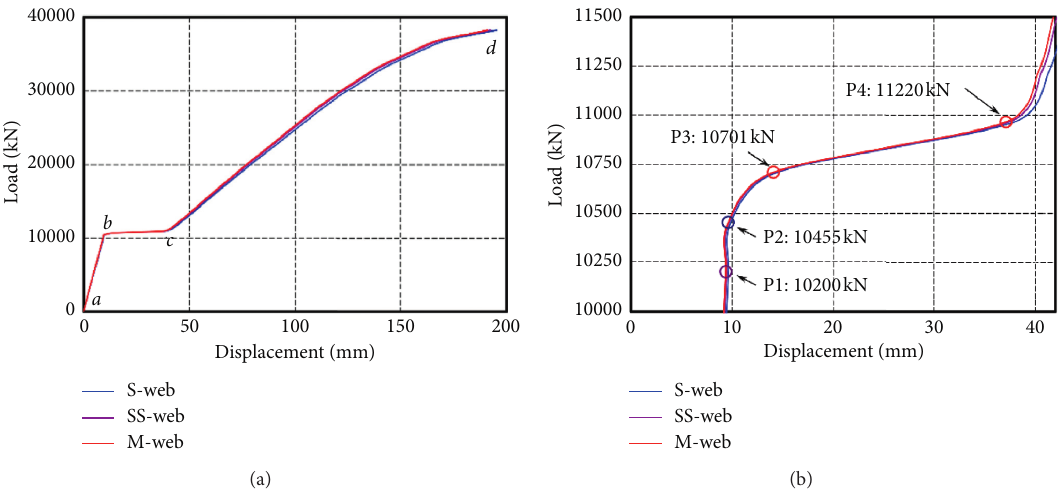
Figure 9: Load-displacement load shear force distribution factor of the S-web From Figure 12: increased to 1.41 ( P � 10965). As the load continued (1) In the elastic phase, the dead load shear force dis- tribution factor remains the same even if the external load changes. The dead load shear force distribution factor of the S-web is greater than 1.0. The shear force distribution factors for S-web, SS-web, and M-web are 1.27, 0.83, and 0.79, respectively. (2) After loading to point P1 (10200 kN), S-web cracked first. After the fluctuation of the local data, the dead